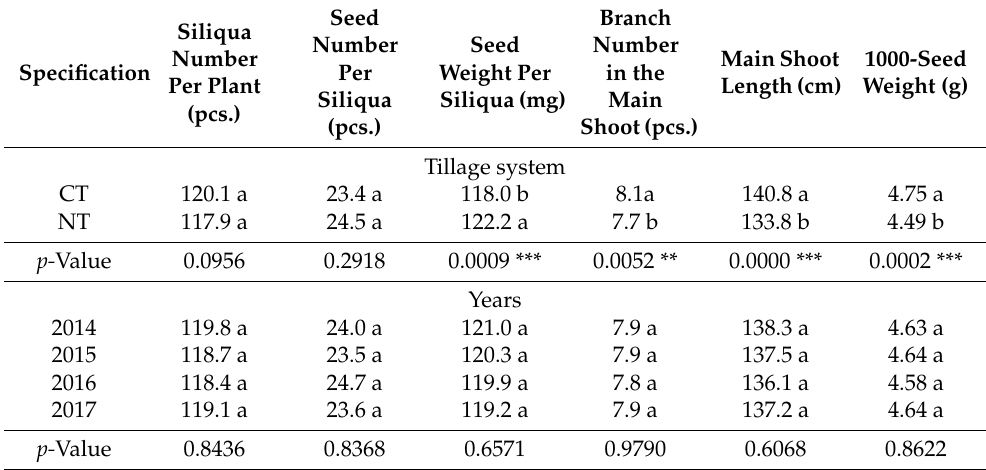
Table 3. Winter oilseed rape yield and crop components depending on the tillage system (mean for 2014–2017) and the research years.